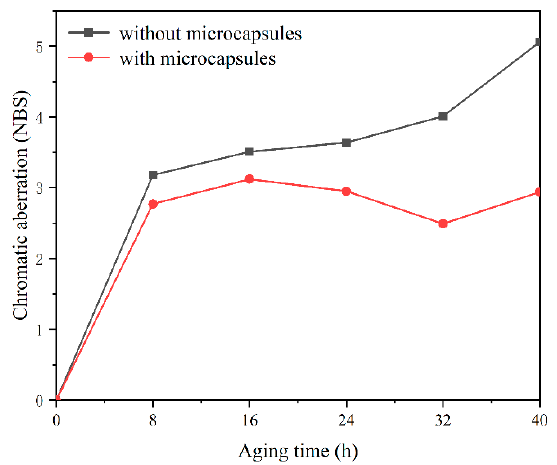
Figure 6. Influence of time on chromatic aberration of coating under 120 ◦ C aging test.